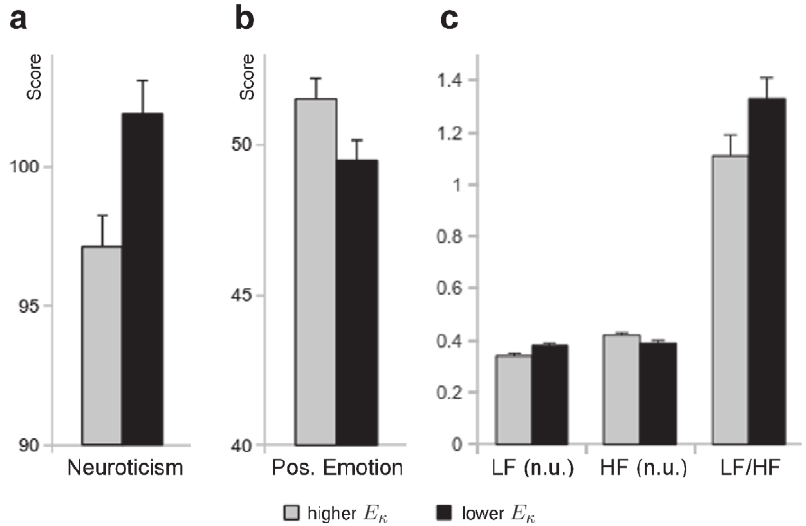
Figure 2. Group comparisons between individuals with E k values above and below the median of E k values. Individuals with higher E k values had lower neuroticism ( a ), and higher positive emotion scores ( b ). Moreover, individuals with higher E k values had lower normalized LF power, higher normalized HF power, and a lower LF/HF ratio ( c ). Abbrevations: LF (n.u.): low frequency power (0.04–0.15 Hz) of the HRV in normalized units; HF (n.u.): high frequency power (0.15–0.4 Hz) of the HRV in normalized units; LF/HF: ratio of low frequency power to high frequency power.